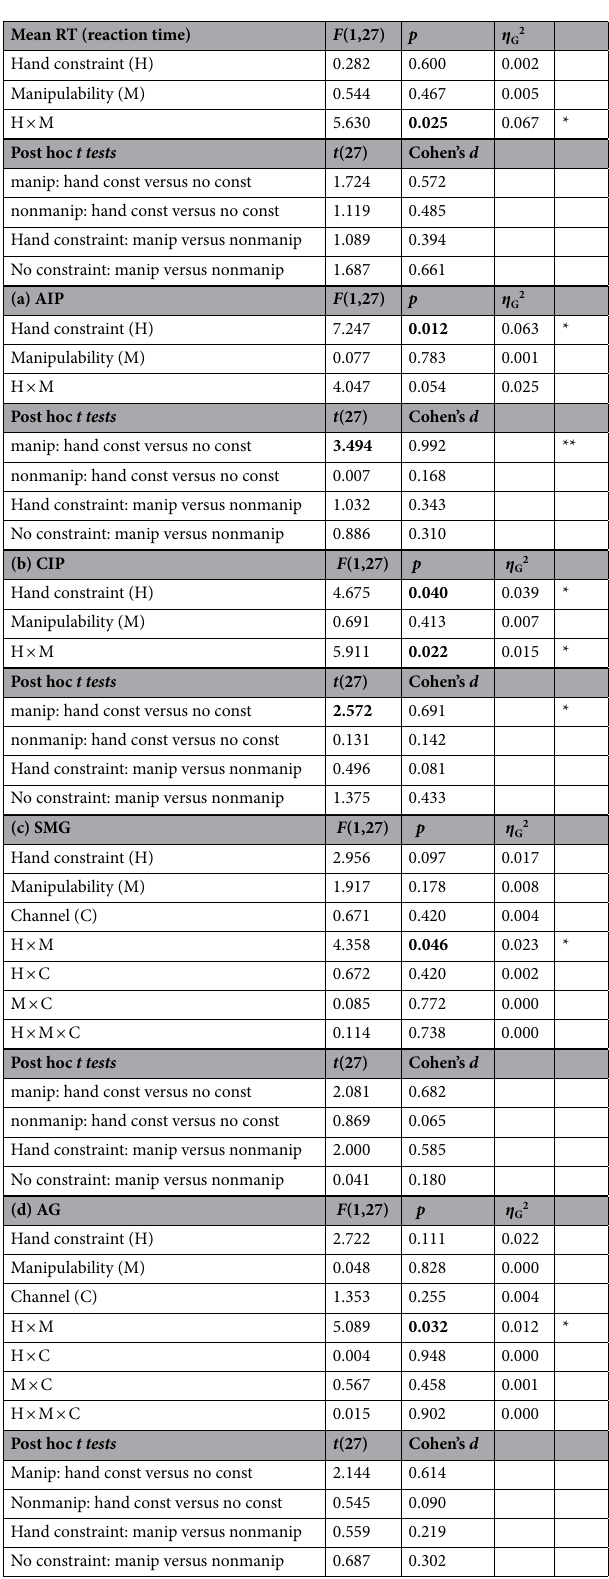
Table 1. The rmANOVA results of the mean RT (reaction time) and mean z score of each ROIs. This table presents the results of repeated measures analyses of variance on the mean z score of the hemodynamic response obtained over the duration of the target phase as well as the mean RT for each participant. FDR corrections were applied to the post hoc t tests to control for multiple comparisons. Significant values are in bold. * p < 0.05; ** p <